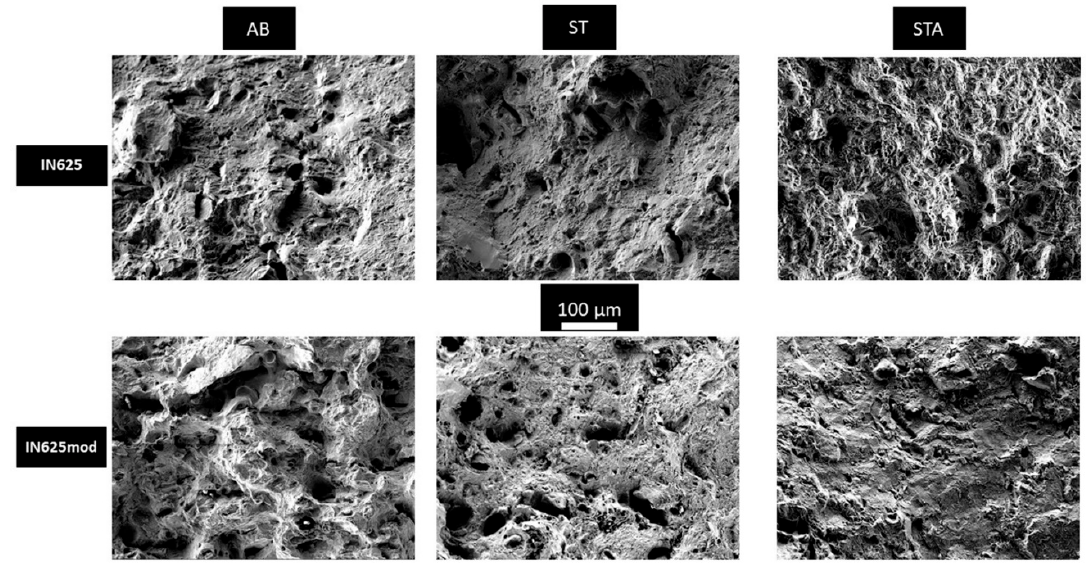
Figure 9. SEM images of the fracture surfaces of the IN625 and IN625mod in the different